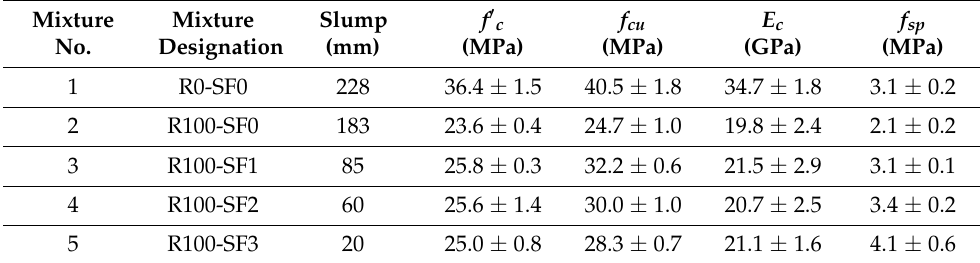
Table 3. Properties of concrete mixtures.